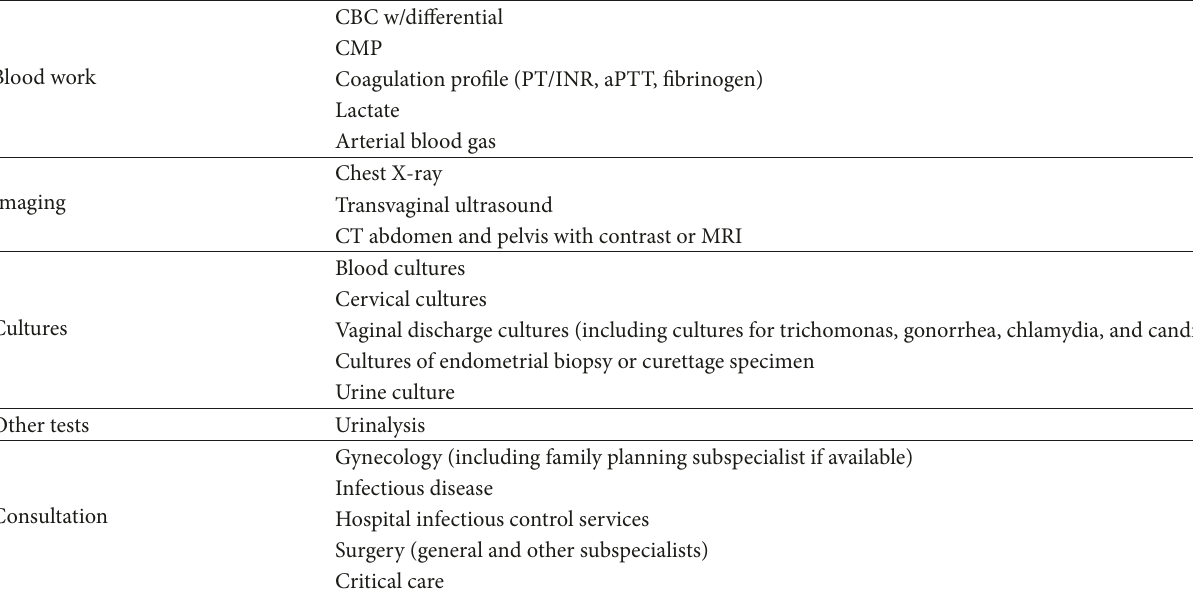
Table 1: Diagnostic work-up for postabortion